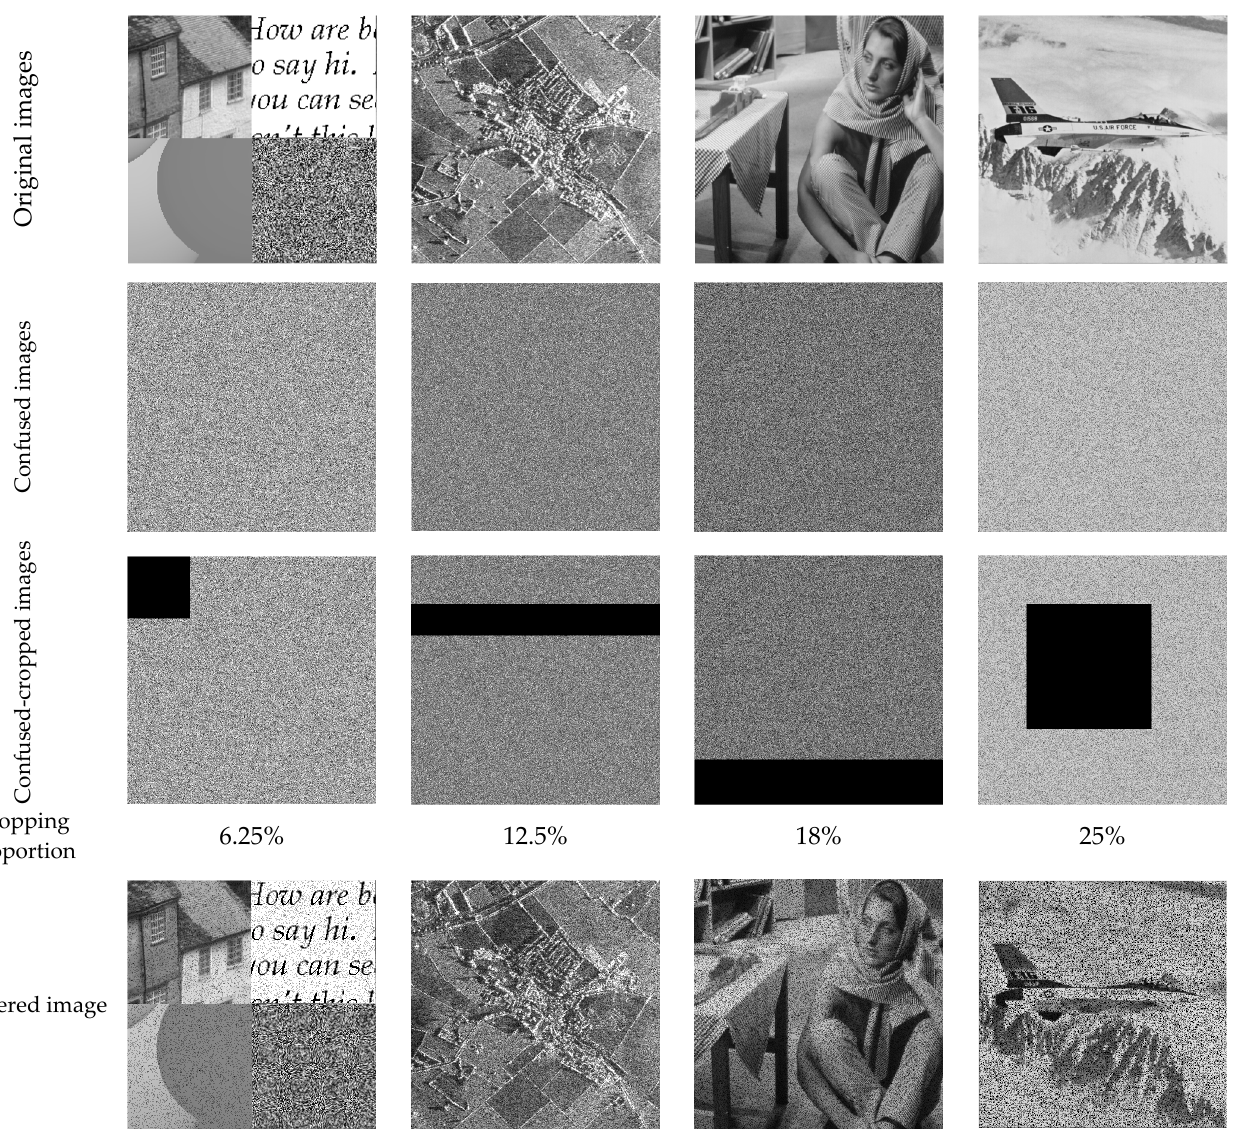
× Figure 13. Standard test images of sizes 512 × 512 with its confused, confused cropped, and recovered Figure 13. Standard test images of sizes 512 512 with its confused, confused cropped, and versions by using the proposed scrambling recovered versions by using the proposed scrambling method.